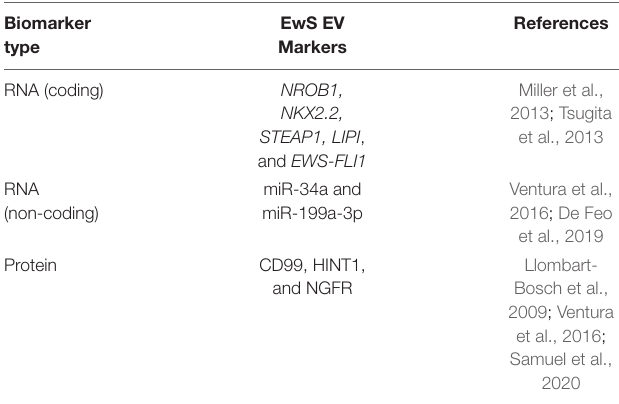
TABLE 2 | Markers of extracellular vesicles derived from Ewing sarcoma